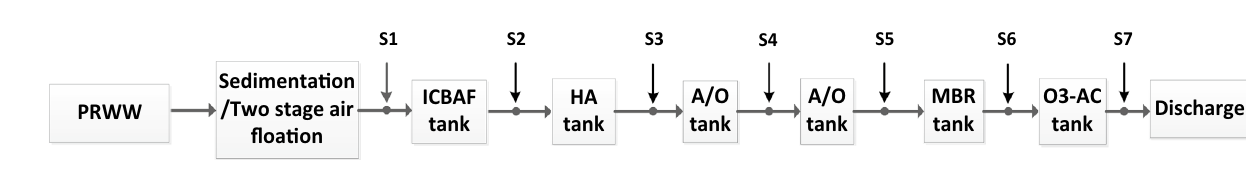
Table 1. Analysis results of six indexes at each sampling point (mg L −1 ). S1-S7 sample point 1–7; ND no detection; COD chemical oxygen demand; BOD 5 Biochemical oxygen demand; TOC total organic carbons; VFA volatile fatty acids.